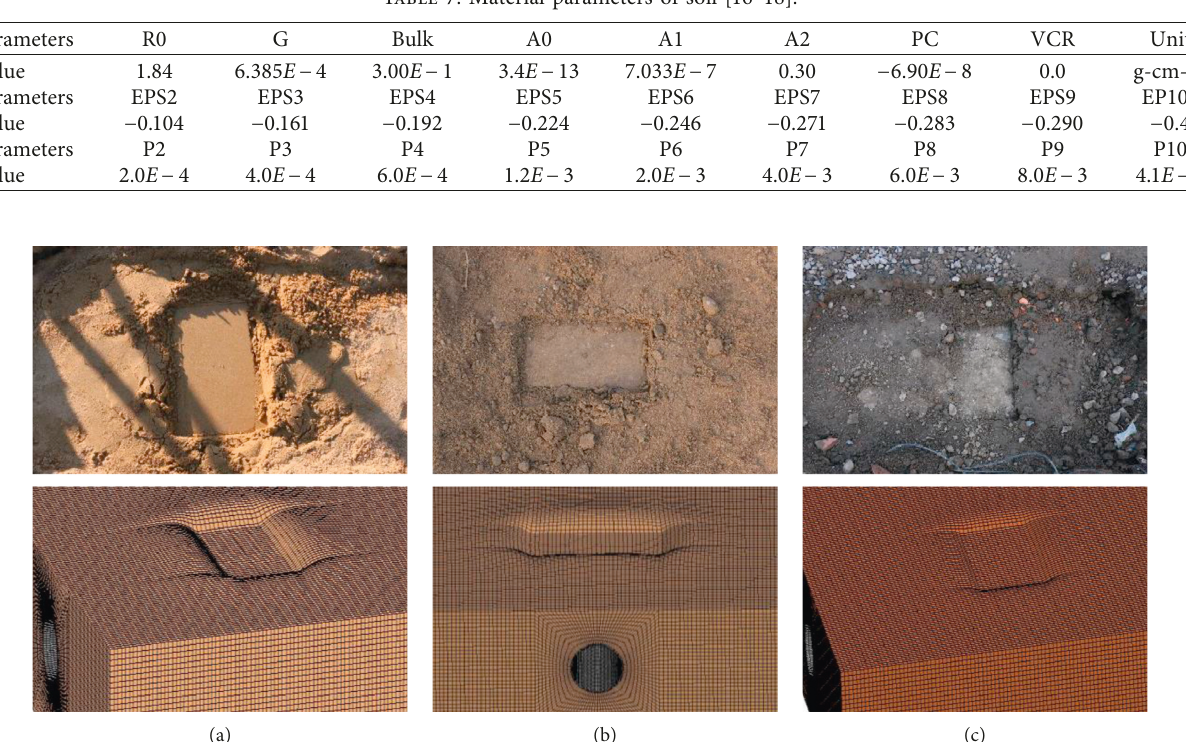
Figure 7: Comparison of deformation between test and numerical simulation. (a) Comparison of working condition 2. (b) Comparison of working condition 5. (c) Comparison of working condition 8.